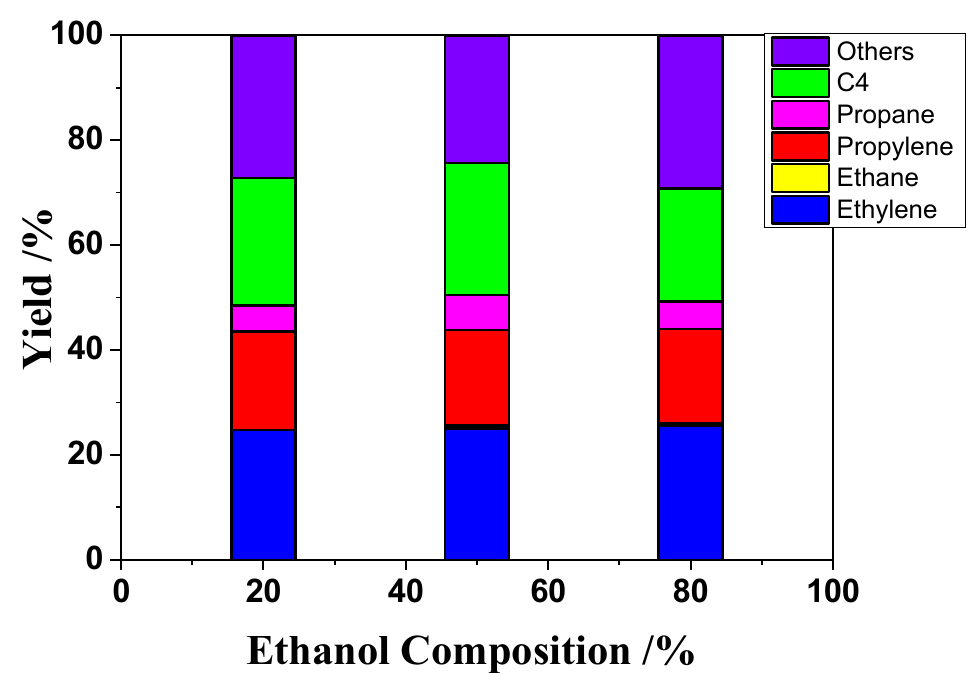
Figure 3. Effect of ethanol composition on ETO reactions over H-ZSM-5(80) catalyst. Temperature, 400 °C; W/F = 0.0025 g/cm 3 ·min − 1 .